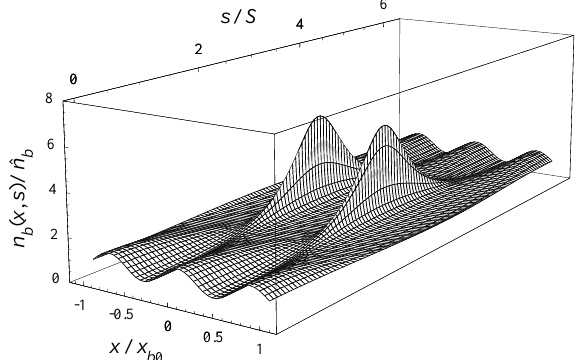
FIG. 11. Plot of laboratory-frame density profile n b (cid:1) x , s (cid:2) (cid:1) n b (cid:4) x 0 (cid:1) x , s (cid:2) , t (cid:1) s (cid:5) obtained numerically from Eqs. (95), (99), and (100) for the choice of system parameters s b (cid:1) 1 , D (cid:1) 0.45 , and k 0 x b 0 (cid:1) 5 p (cid:3) 2